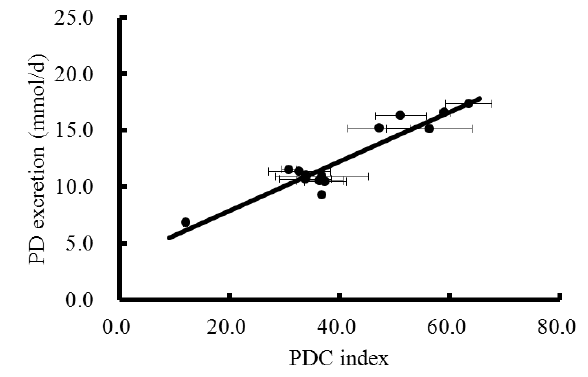
Figure 2. Correlation between PD excretion (Y, mmol/d) and PDC index (X) in three periods of spot urine samples: Y = 0.22X+3.55, R 2 =